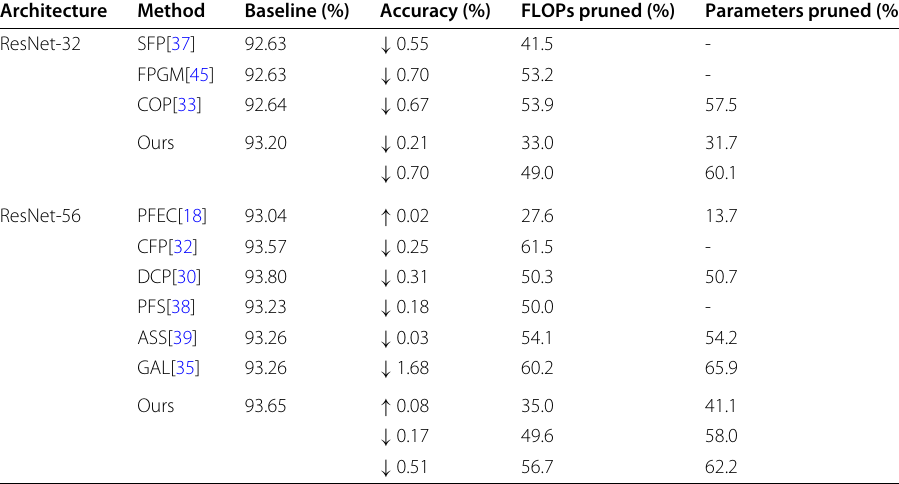
Table 3 Results of pruning ResNet on CIFAR-10